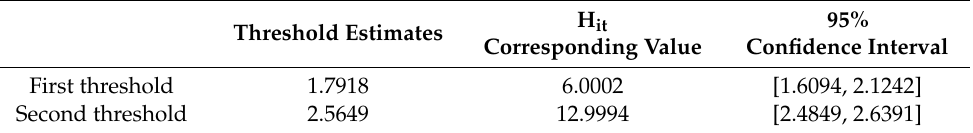
Figure 5. Threshold estimates and their confidence intervals. Table 5. Threshold estimates and their confidence